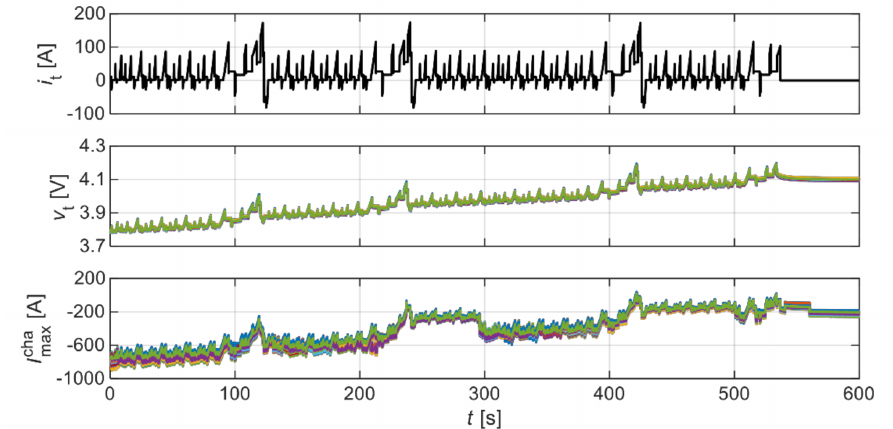
Figure 4. Experiment results of i t , v t , and I cha max of all cells while the battery pack with cell inconsistency is charged with NEDC.